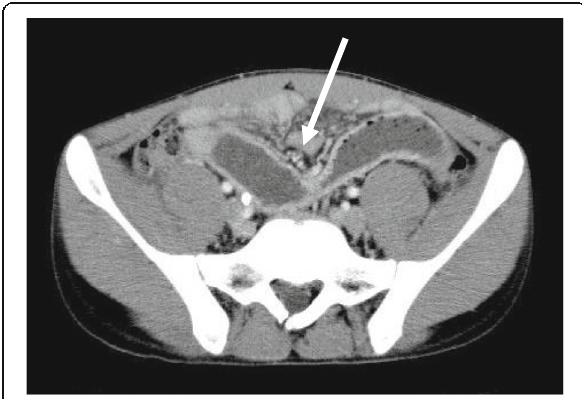
Fig. 1 CT showing stenosis of the small bowel and dilatation of the oral small bowel